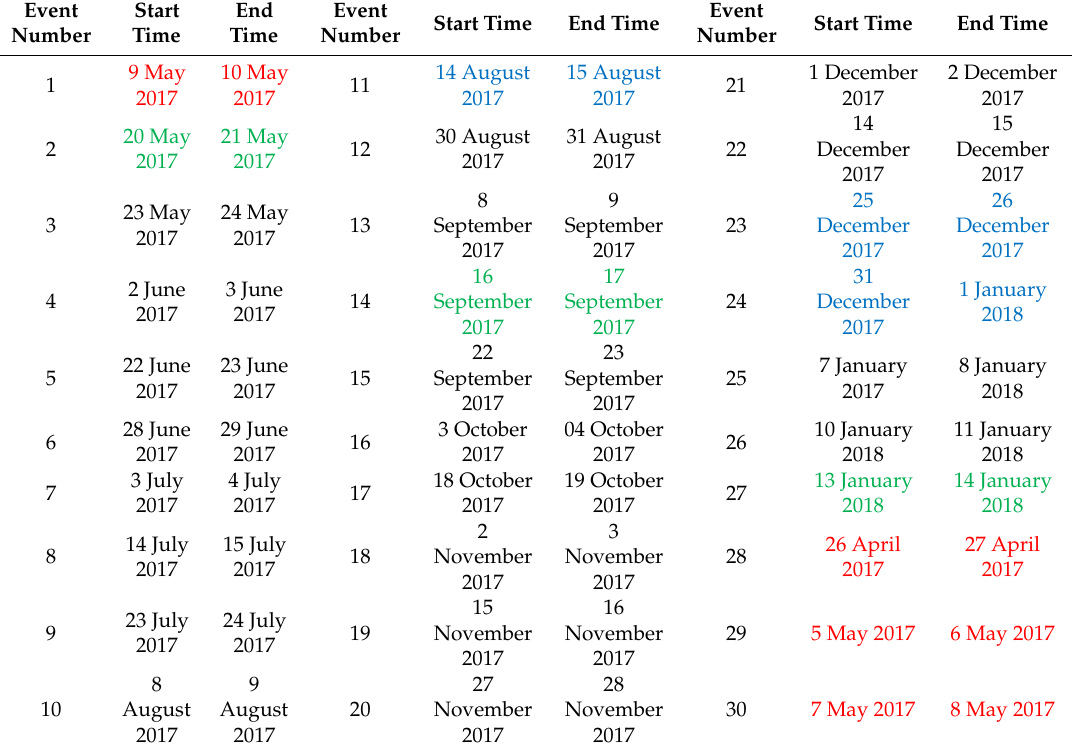
Table 1. Summary of the measurement days included in the analysis (blue: holidays, red: pre-failure, after and failure days, green: weekends, black: working